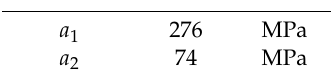
Figure 6. Experimental setup.